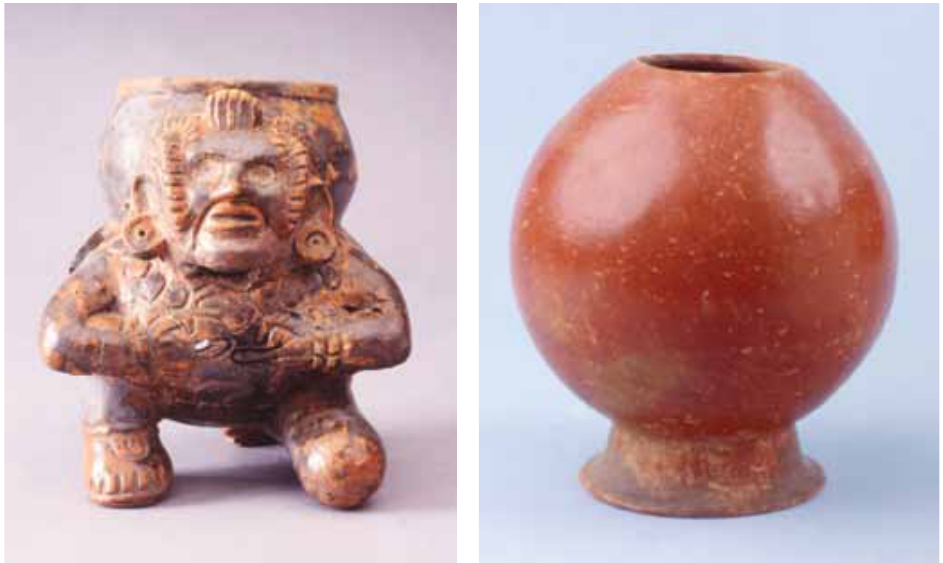
Fig. 4: Ceramic vessels from under-floor burials at Marco Gonzalez: (left) a vessel depicting a man on one knee, from highland Guatemala; and (right) a red-slipped vase with ped- estal base, from the central Belize